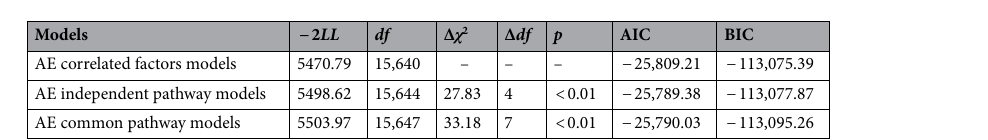
Figure 1. Path diagrams of multivariate genetic models: ( A ) correlated factors model (transformed from full Cholesky decomposition), ( B ) independent pathway model, and ( C ) Common pathway model, showing one twin only for simplicity.